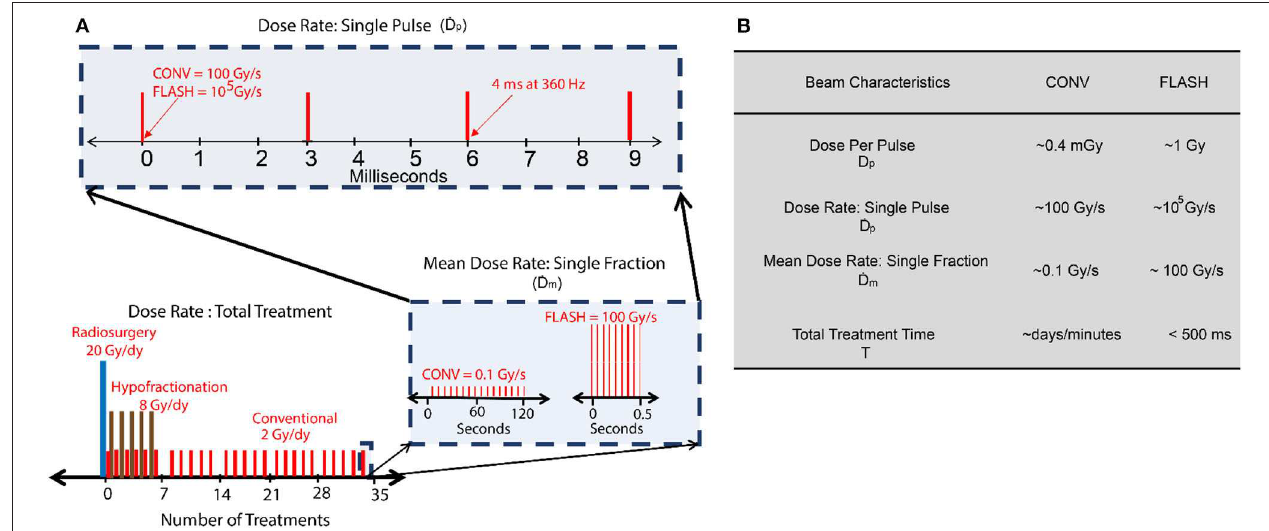
FIGURE 3 | (A) Dose rate schemes in radiation therapy indicating different interpretations of dose-rate. (B) Typical temporal beam characteristics for conventional (CONV) and FLASH using